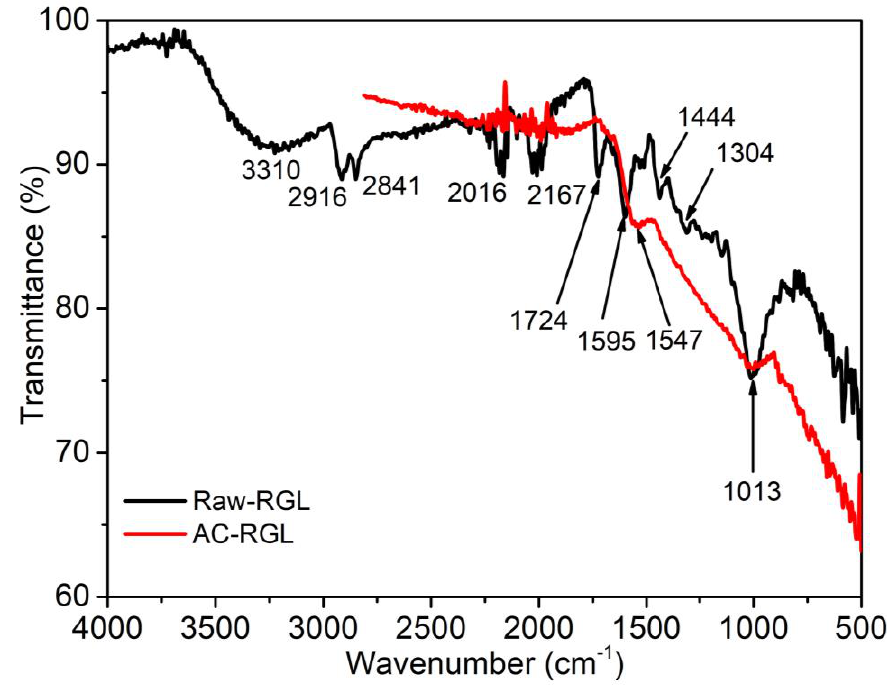
Figure 13. FTIR spectra of Raw-RGL and AC-RGL adsorbents after adsorption.